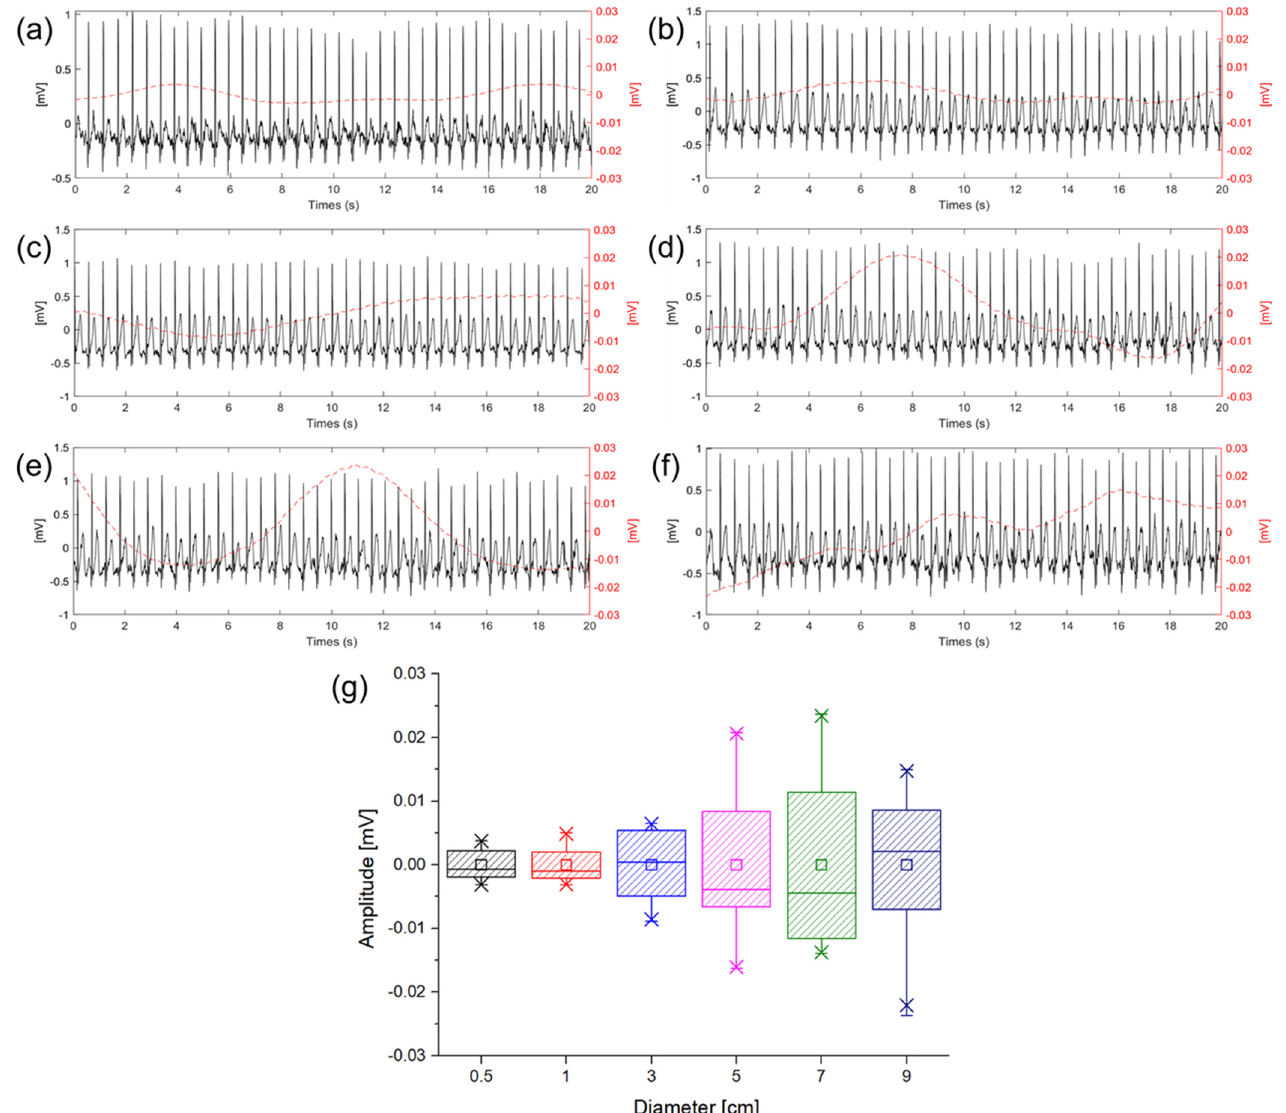
Figure 8. Baseline wandering according different electrode diameter of ( a ) 0.5 cm(black), ( b ) 1 cm(red), ( c ) 3 cm(blue), ( d ) 5 cm(violet), ( e ) 7 cm(green), ( f ) 9 cm(indigo), and ( g ) box plot of baseline wandering amplitude according to the diameter of electrode.